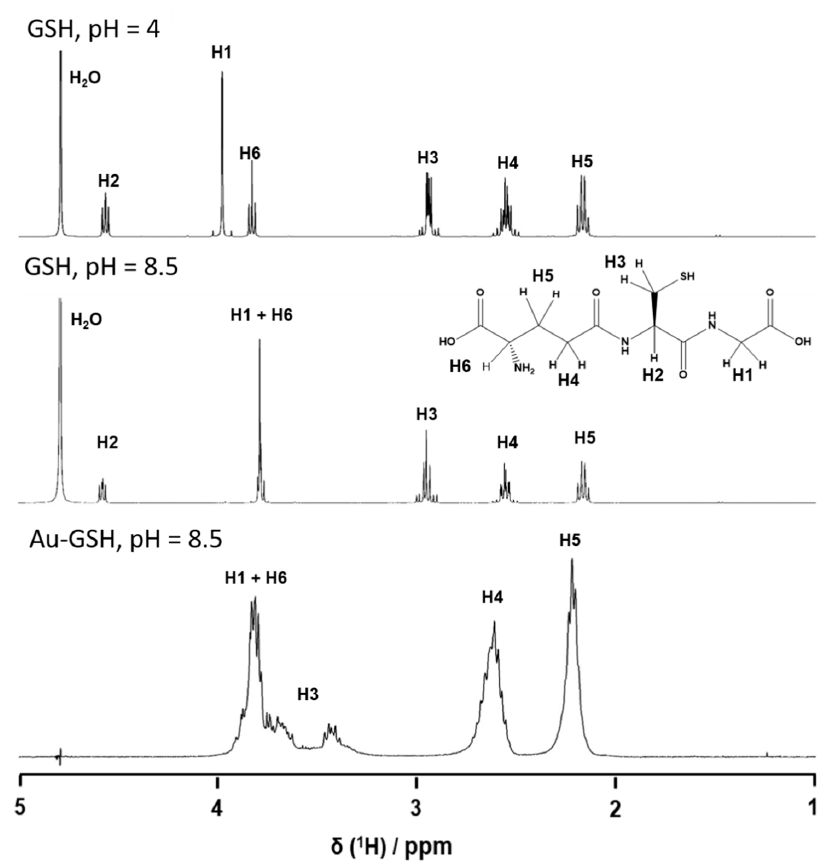
Figure 4. 1 H-NMR spectra of dissolved glutathione (GSH; pH 4.0 and pH 8.5) and of glutathione- functionalized ultrasmall gold nanoparticles (Au-GSH; pH 8.5).